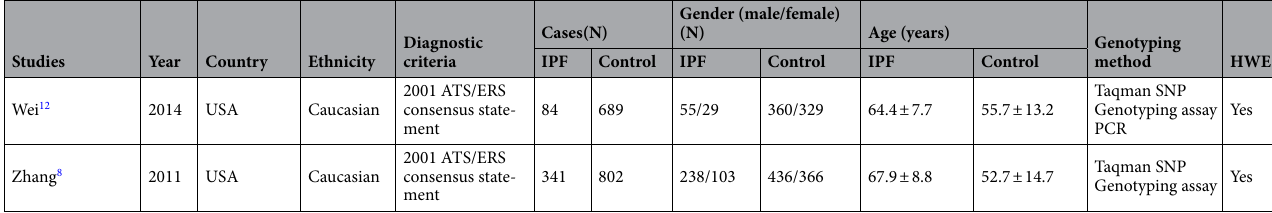
Table 1. Basic features of the included study. ATS American Thoracic Society, ERS European Respiratory Society, JRS Japanese Respiratory Society, ALAT Latin American Thoracic Society, IPF idiopathic pulmonary